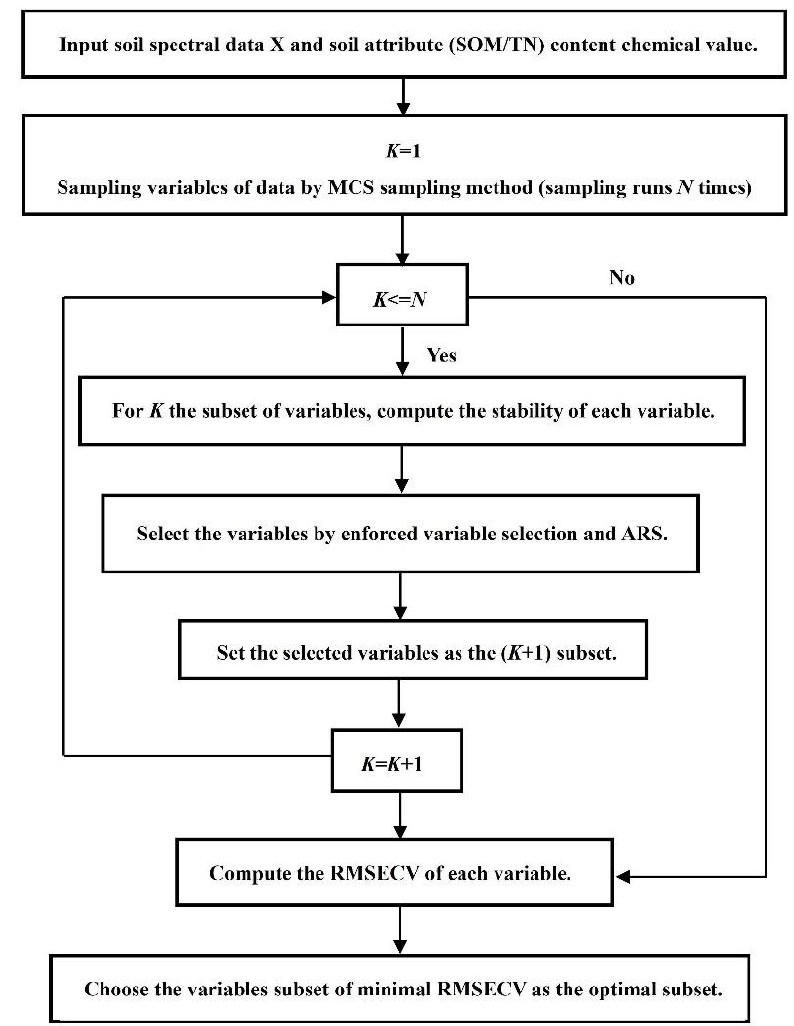
Figure 3. The flow chart of the sCARS